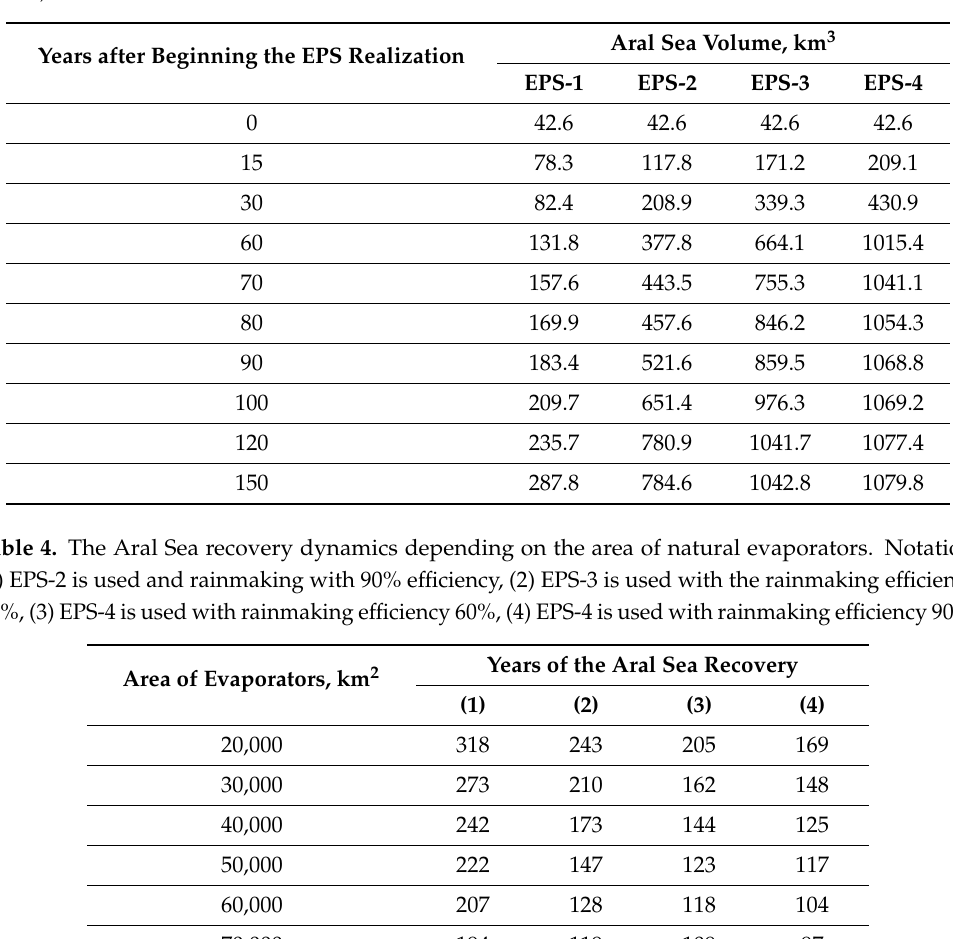
Table 3. Recovery chronology of the Aral Sea volume when the Evaporation / Precipitation Scenarios (EPS’s) are realized.